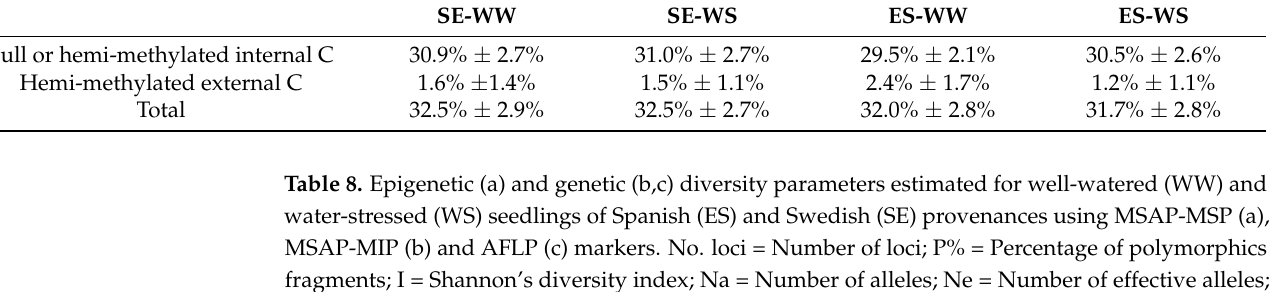
Table 7. Percentage of analyzed methylated restriction sites (mean values ± SD) of well-watered (WW) and water-stressed (WS) seedlings from Spanish (ES) and Swedish (SE) provenances. SE-WW SE-WS